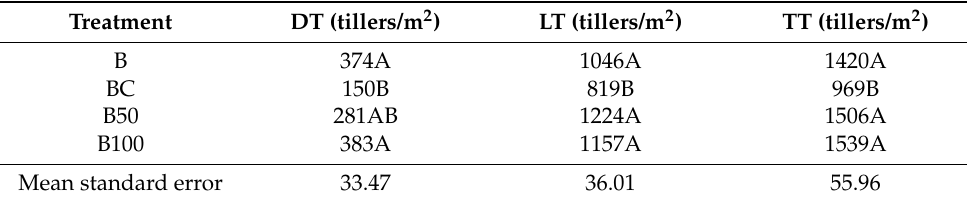
Table 6. Averages of the numbers of dead tillers (DTs), live tillers (LTs), and total tillers (TTs) for the different treatments at the end of the deferral